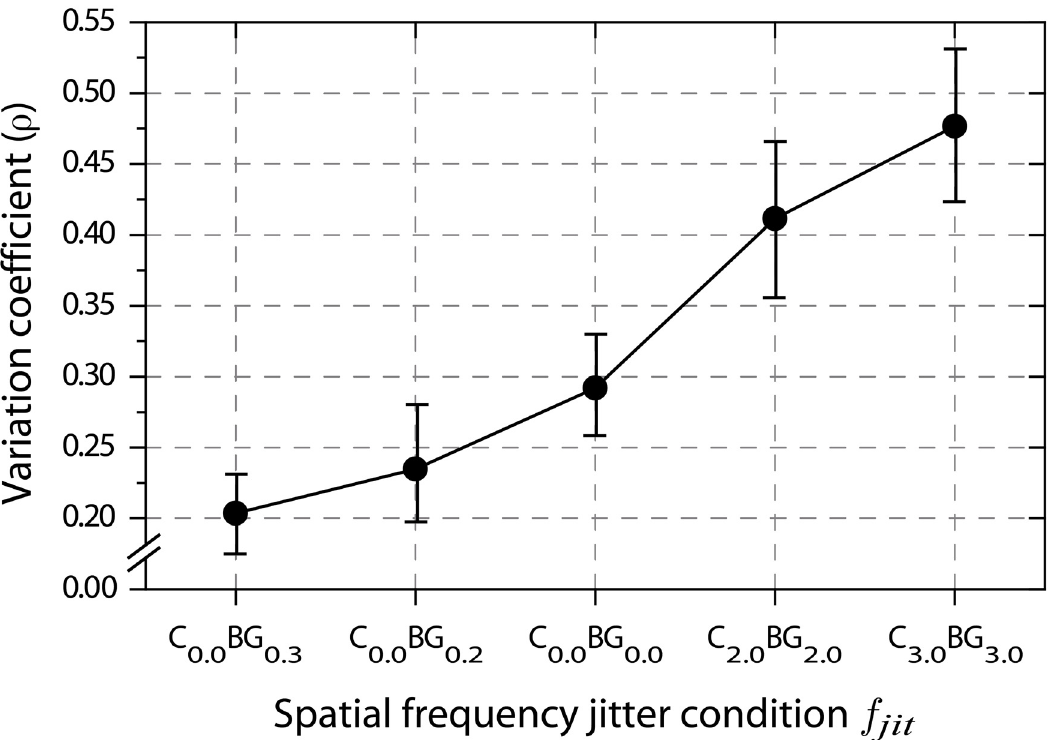
Fig 6. Variation coefficients. Coefficients are computed as r ¼ s y